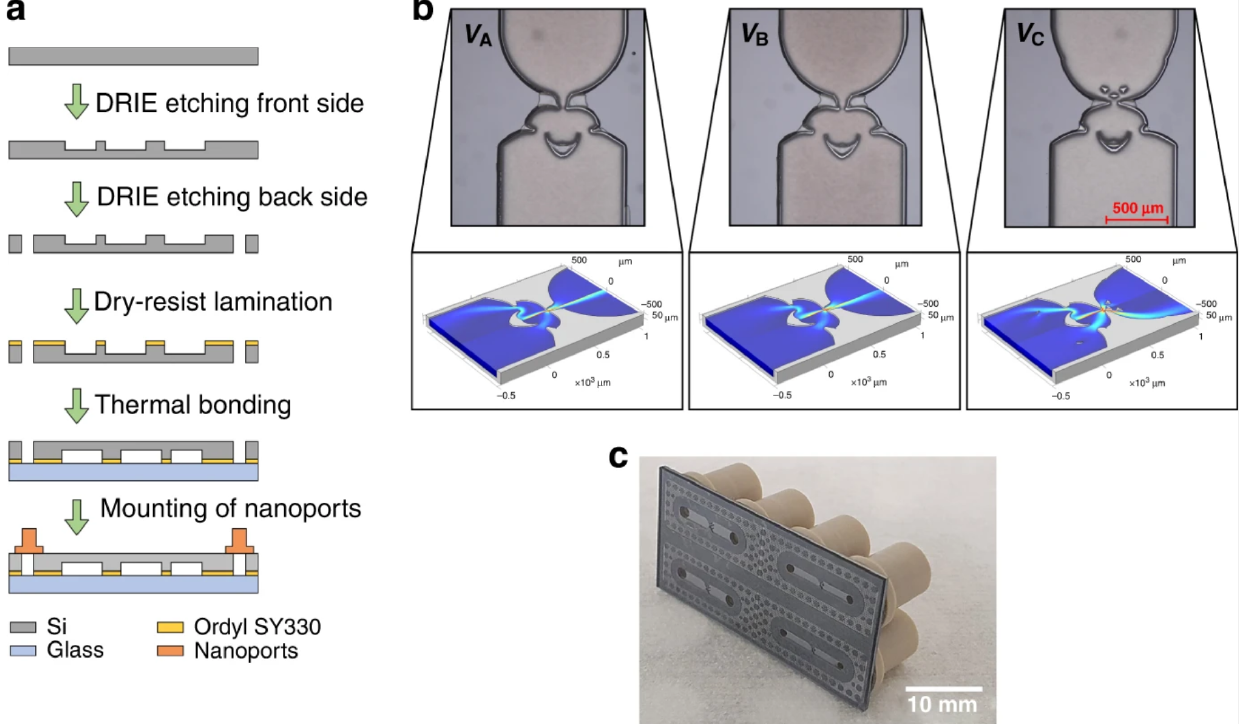
Figure 5. The TV derivative design and its fabrication process. ( a ) Lithography and bonding process of the TV derivative microfluidics. ( b ) A computational fluid dynamic (CFD) simulation optimizes the TV channel. ( c ) The microfluidics image with TV-derivative design. Reprinted from [18] under Creative Commons license.